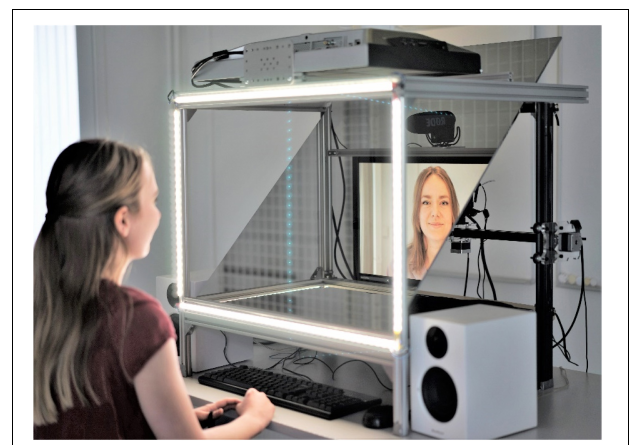
FIGURE 2 | Demonstration of a conversation conducted in the